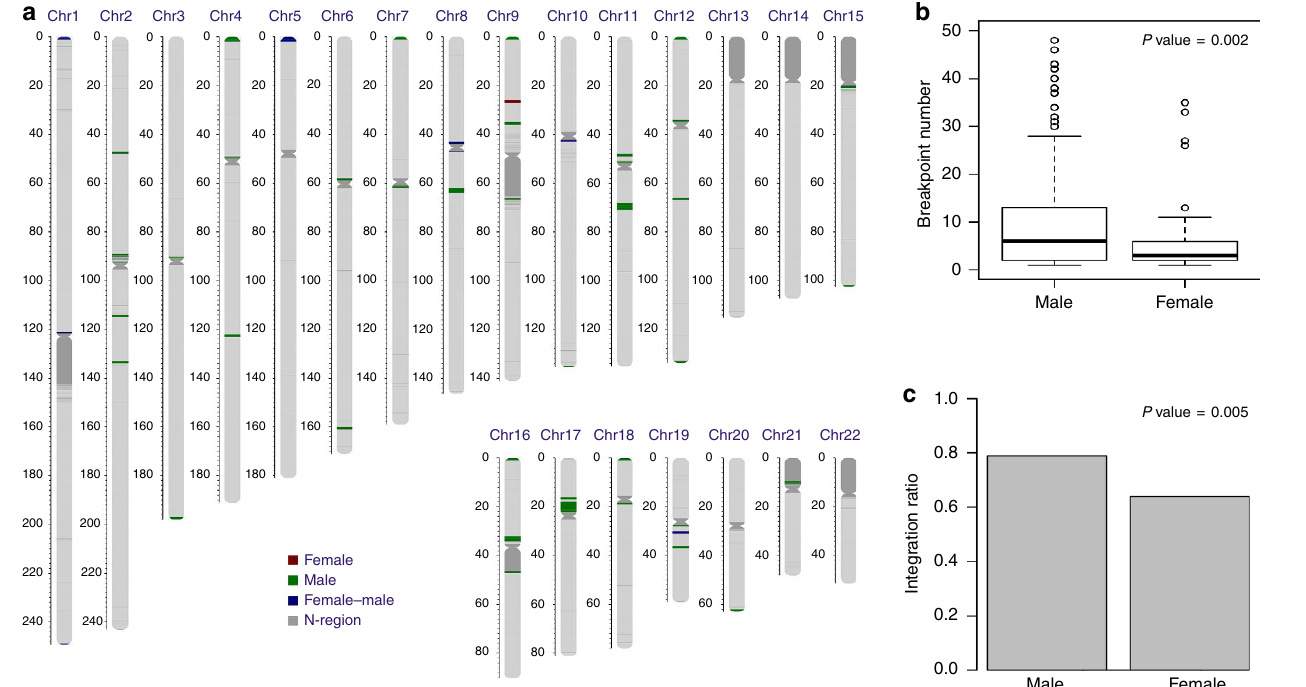
Figure 6 | HBV integration preference in male versus female HCC samples. ( a ) Distribution of the enriched HBV integration regions in tumour samples. The red bars indicate the enriched regions found only in female samples, green bars represent enriched regions only found in male samples, and blue bars mean enriched regions found in both. In every 1M window of chromosomal region, the observed number of integration sites was tested against the expected number where all integrations distributed randomly across the genome. Enrichment was defined as P value smaller than 0.05 calculated by w 2 test, which was performed separately in male and female samples. ( b ) Comparison of the numbers of breakpoints in tumour tissues of male and female samples. The HBV breakpoints number of male (left) and female (right) are shown. The box plots show the median (horizontal bar), 25th and 75th percentiles, and the whiskers of the plots show the smallest and largest values. P values was calculated by unpaired Student’s t test. ( c ) Comparison of integration ratio of male and female HCC samples. The HBV integration ratio of male (left) and female (right) HCC samples are shown. P values were calculated by w 2